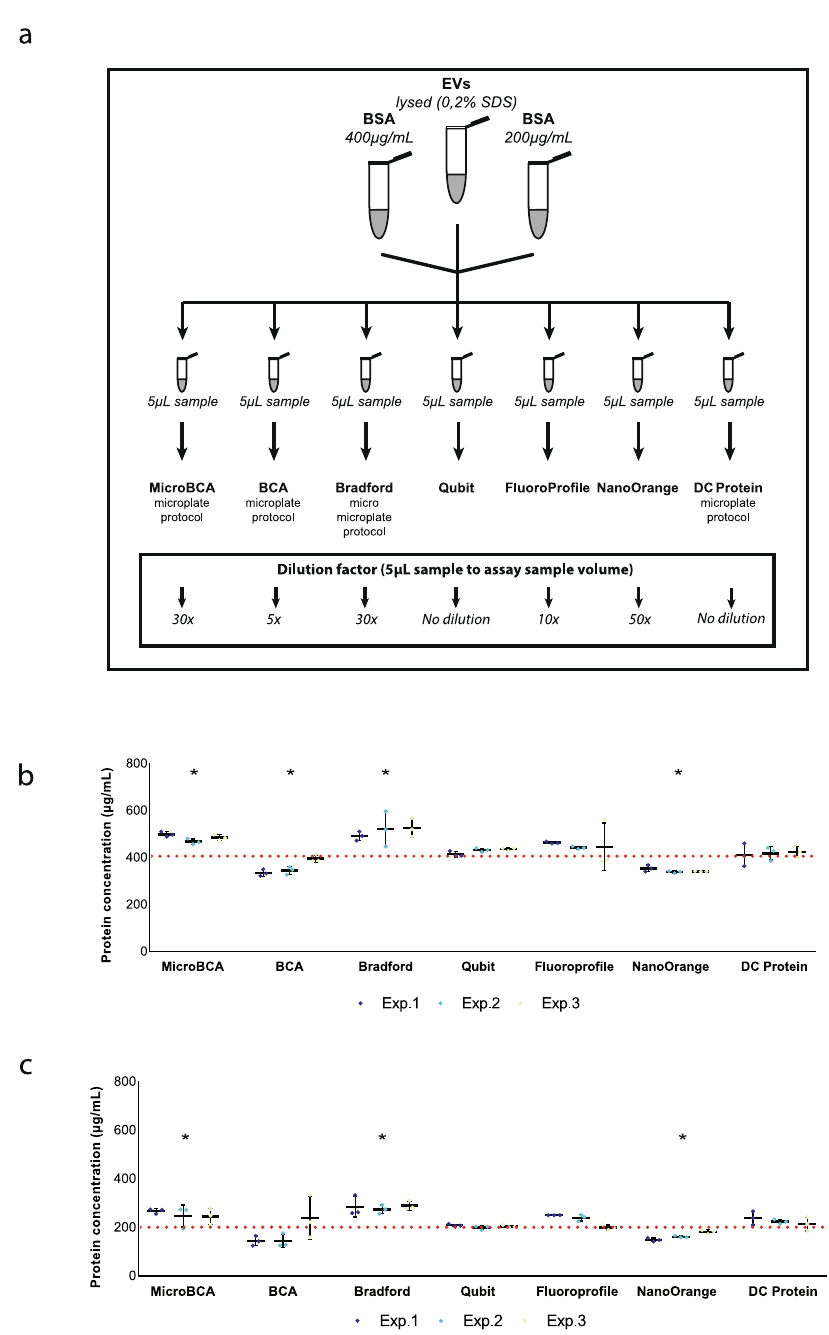
Figure 4. Comparison of the performance of different protein assays to measure protein concentration of BSA and EV samples. ( a ) Seven different protein assays (four colorimetric, three fluorometric) were compared using three different samples: BSA 400 µ g/mL, BSA 200 µ g/mL and EV sample. Identical sample volume was used in all assays and proper dilution to working sample volume was implemented. ( b,c ) All protein assays were performed on two known BSA concentrations: ( b ) 400 µ g/mL (n = 3, * p < 0.003) and ( c ) 200 µ g/mL (n = 3, * p < 0.05). Red dotted line indicates known BSA concentration. Mean values + SD are indicated. Significant differences were calculated using Student’s t-test with Qubit as reference. Abbreviations: EV: extracellular vesicle. BSA: bovine serum albumin. Exp.: